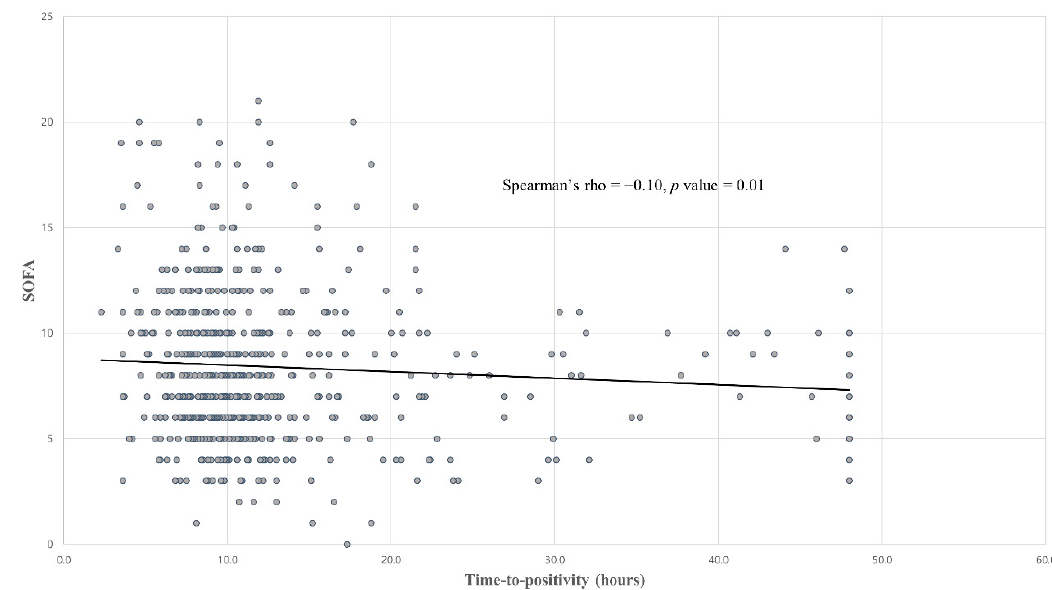
Figure 3. Correlation between the TTP and SOFA scores. Abbreviations: TTP = Time-to-positivity, SOFA = Sequential organ failure assessment.